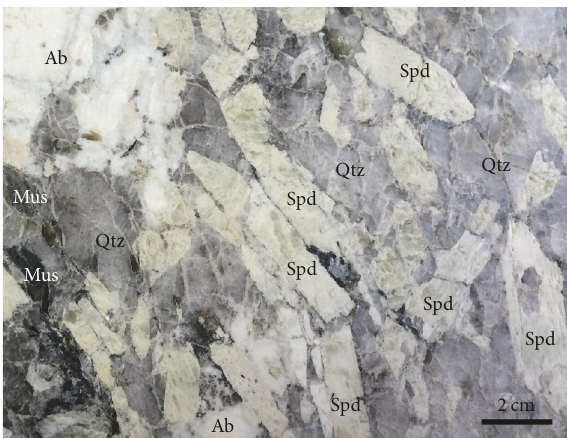
Figure 3: The sample photo of spodumene belt in number 134 dike in the Jiajika deposit, showing the coexistences of spodumene, quartz, albite, and muscovite. Spd: spodumene, Al: albite, Qtz: quartz, and Mus: